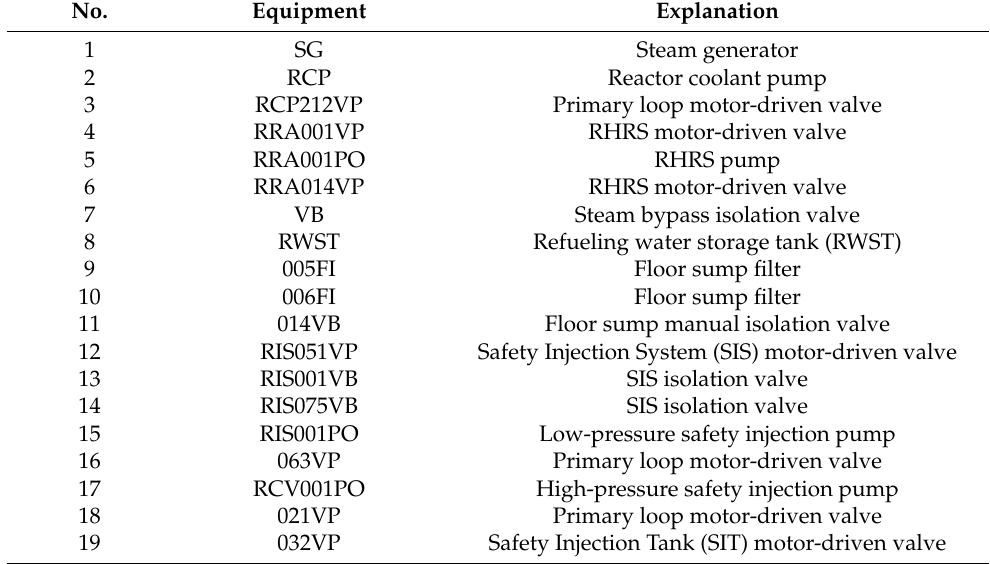
Table 1. Description of the equipment in Figure